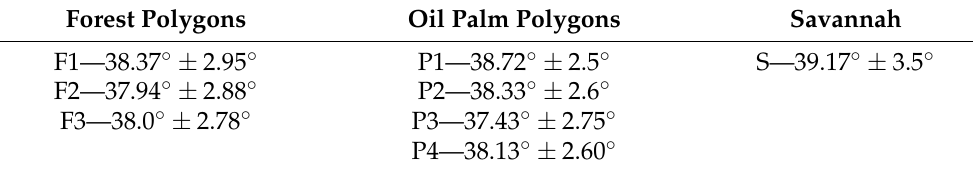
Table 5. Mean and standard deviation of the local incidence angle (degree) for all pixels inside each polygon considered for this